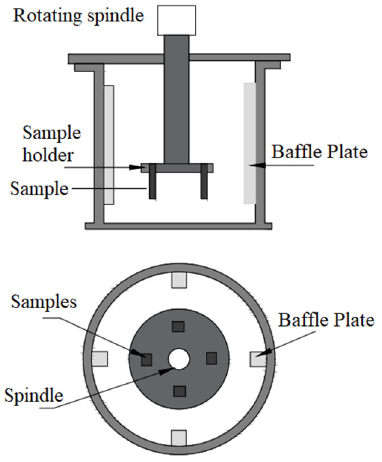
Figure 2. Slurry erosion test